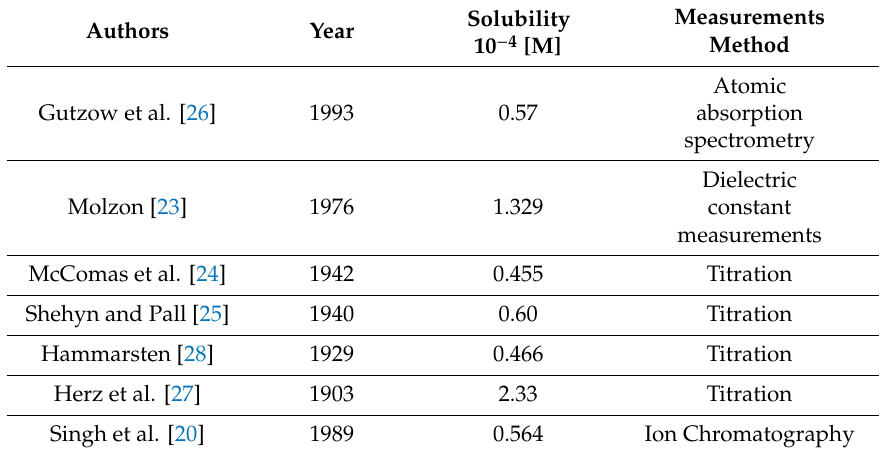
Table 1. The solubility of CaOx in pure water at 25 ◦ C. In reports provided below, hydrate form of dissolved CaOx has not been reported or characterized hence we can refer them as CaOx solubility unless hydrate form is explicitly